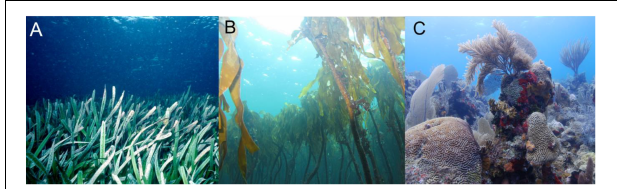
FIGURE 1 | Examples of ocean ecosystems threatened by widespread loss due to climate change. (A) Seagrass bed in Australia (T. Wernberg), (B) kelp forest in Norway (K. Filbee-Dexter), and (C) coral reef in Honduras (A.